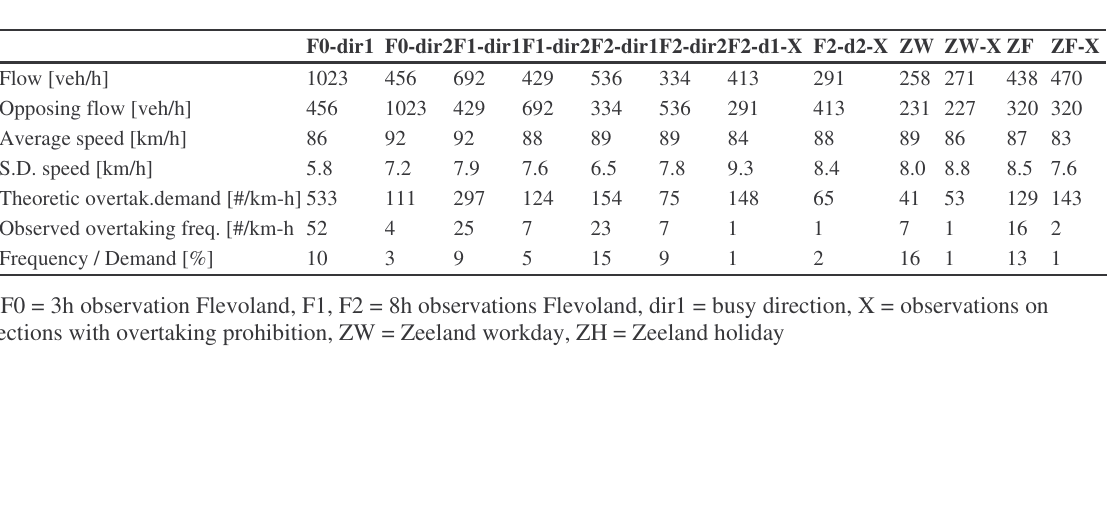
Table 1. Observed overtaking frequency and theoretical overtaking demand